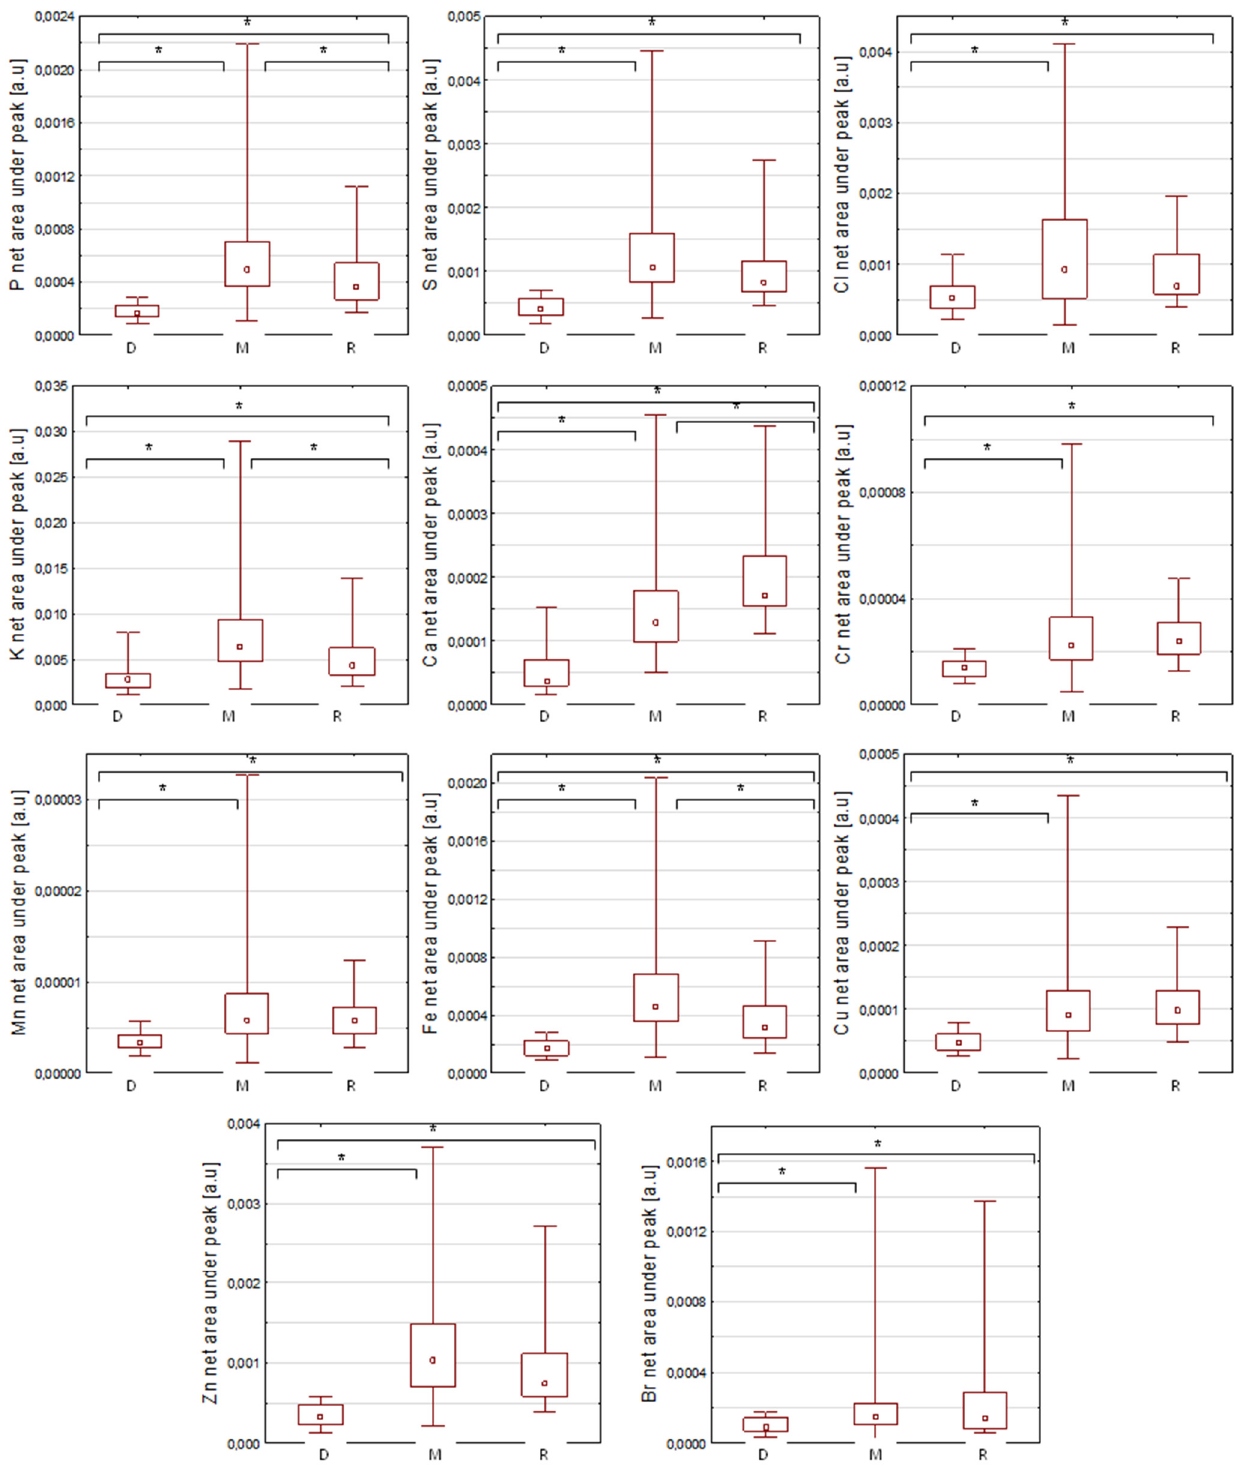
Figure 3. Box plots from the Kruskal–Wallis test for the individual elements (median, ± 0.25–0.75% percentile and min–max values). Abbreviations: *— p < 0.05; D—dystrophies group; M—myopathy group; R—reference group.